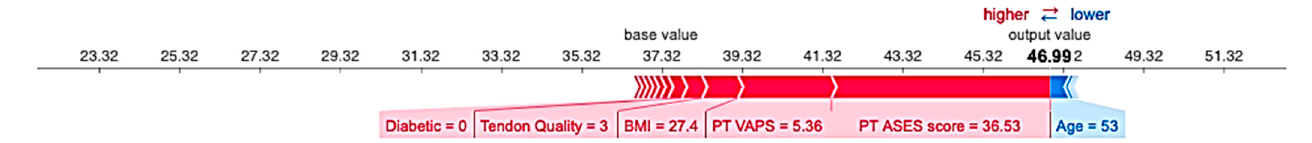
Figure 6. Relative importance of various features on the prediction of 12-month post-operative ASES score.